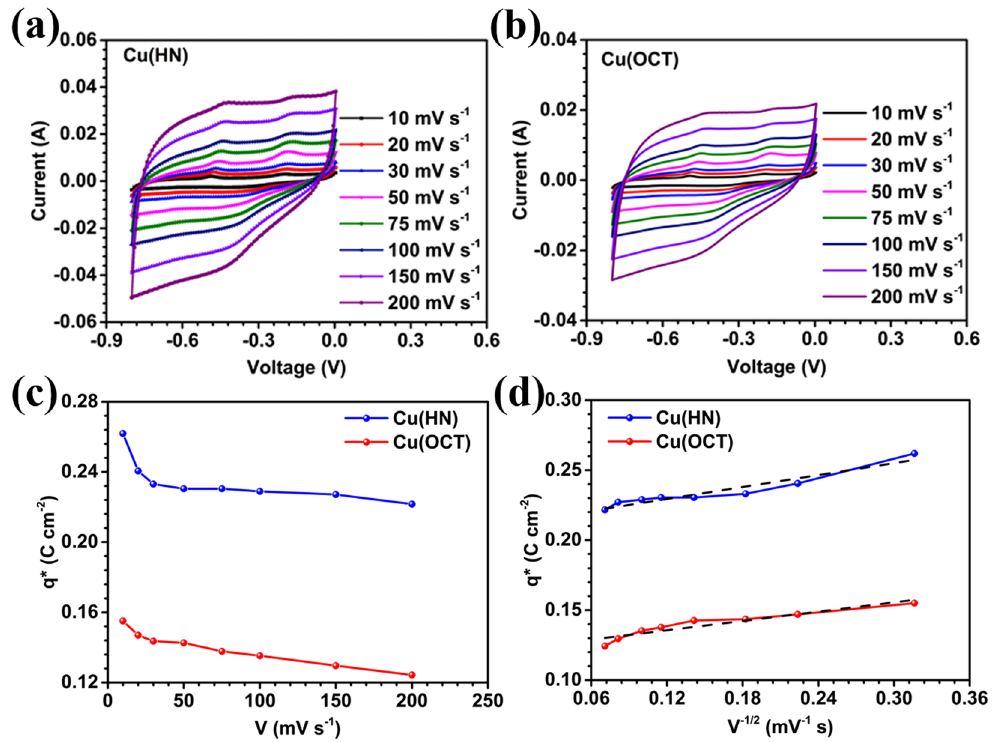
Figure 3. CV profiles of ( a ) Cu(HN), ( b ) Cu(OCT) at different scan rates, ( c ) Voltammetric charge at different scan rates for Cu(HN) and Cu(OCT) and ( d ) voltammetric charge q * plot as a function of V − 1/2 , where V is scan rate. The double layer charge (q 0 ) is determined at the V − 1/2 = 0 corresponding to the intercept of the fitting line.